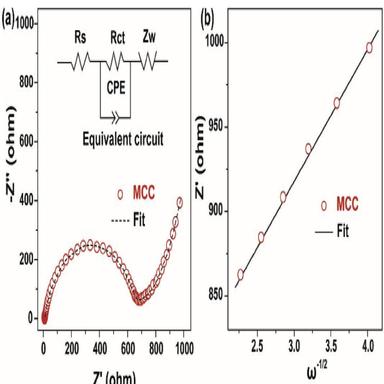
(a) The Nyquist plots of EIS and the fitting results for P2-MCC electrode after standing, the inset is the corresponding equivalent circuit; (b) The dependence of Z' on the reciprocal square root of the frequency (u1/2) in the low-frequency region.